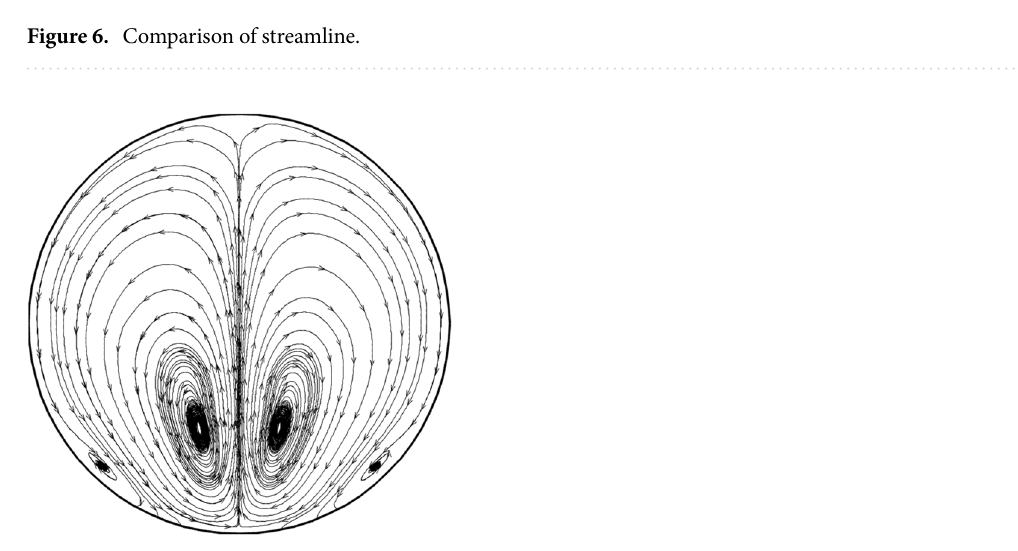
Figure 7. The flow stream in the mid-section of the tube in existence of the magnetic